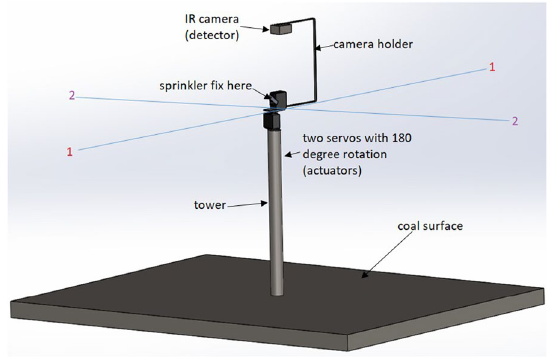
Fig. 2 Pole design used in the